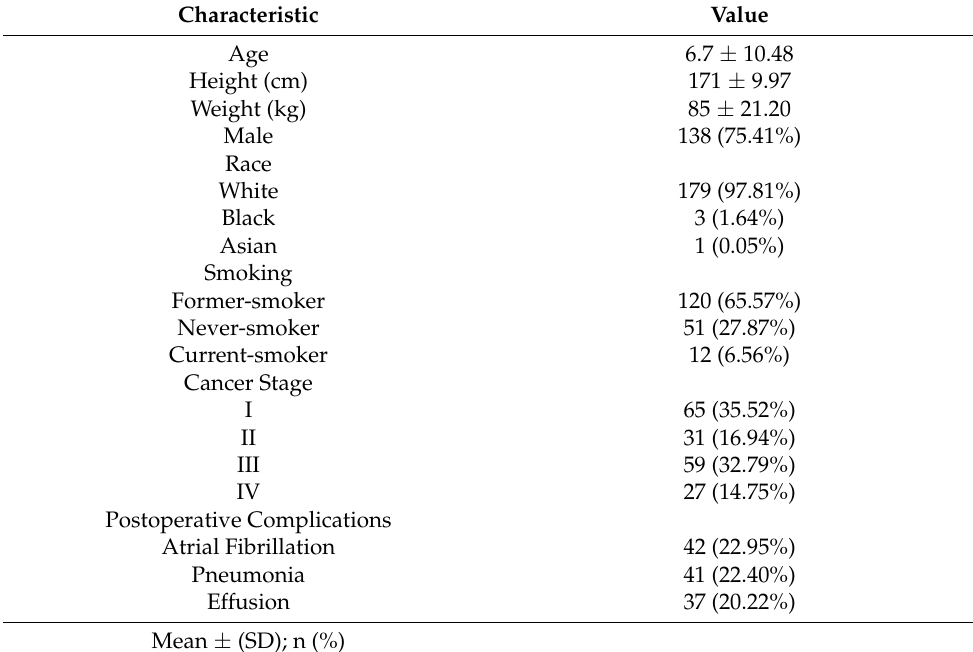
Table 1. Baseline demographics (n = 183).